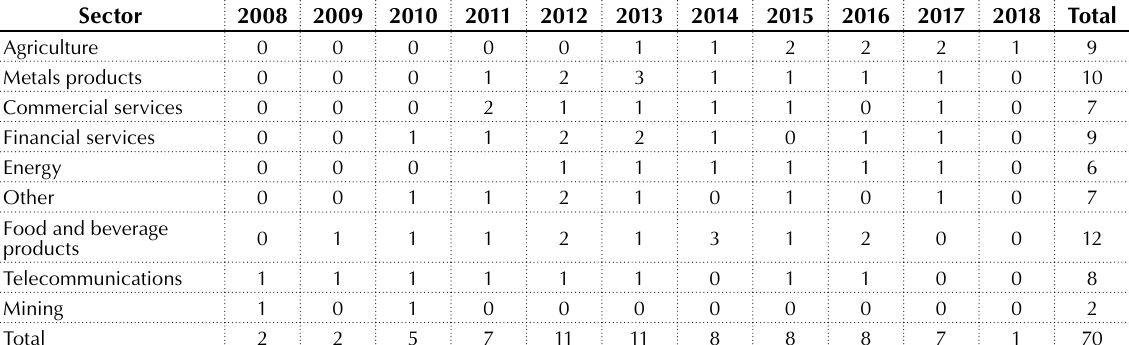
Source: compiled by the authors according to GRI SDD